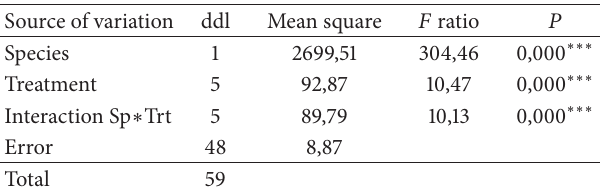
Table 1: Results of a two-way ANOVA showing effect of water stress on the germination rate in both species: Ziziphus lotus and Rhus tripartitum .